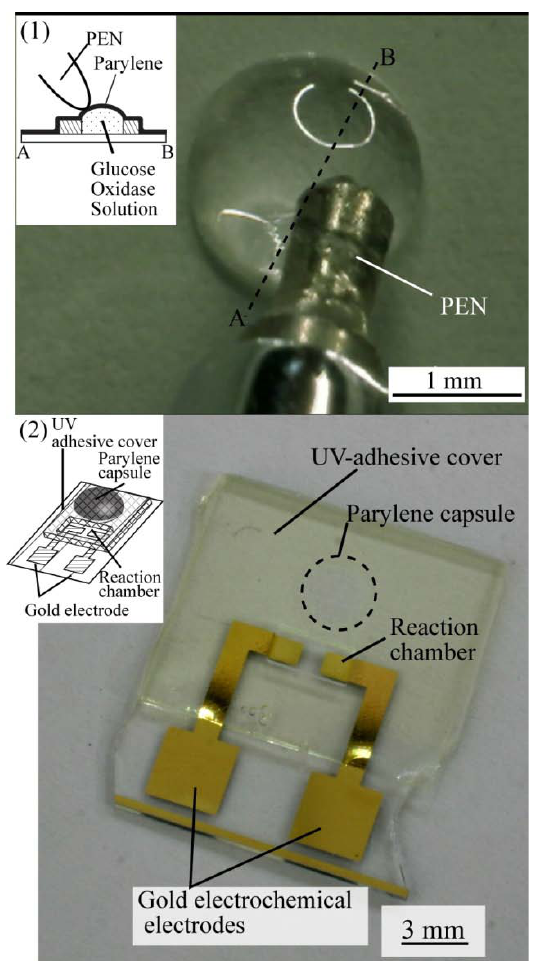
Figure 4 . Fabricated